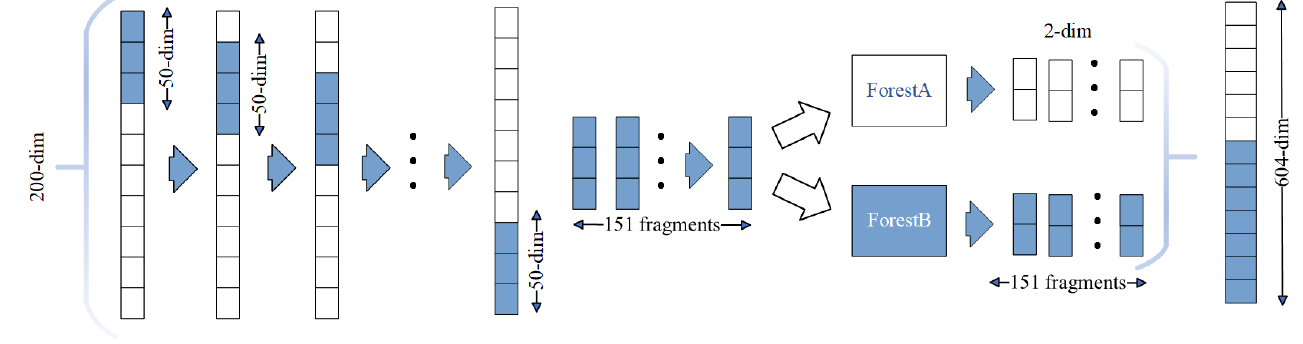
Figure 3. Diagram of multigranularity scanning process.